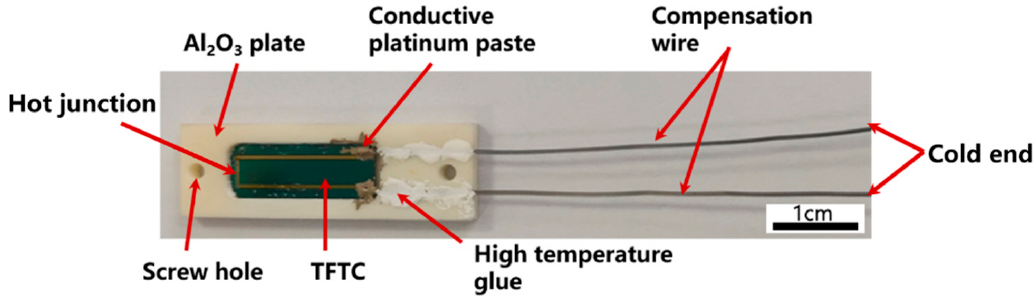
Figure 3. Connection of compensation wires.